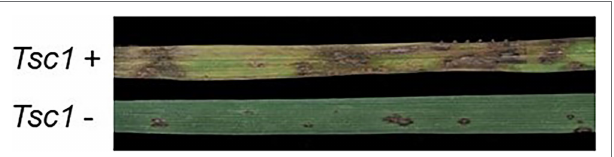
FIGURE 1 | Leaves of wheat genotypes with Tsc1 (top) and without Tsc1 (bottom) inoculated with a Pyrenophora tritici-repentis ( Ptr ) ToxC-producing